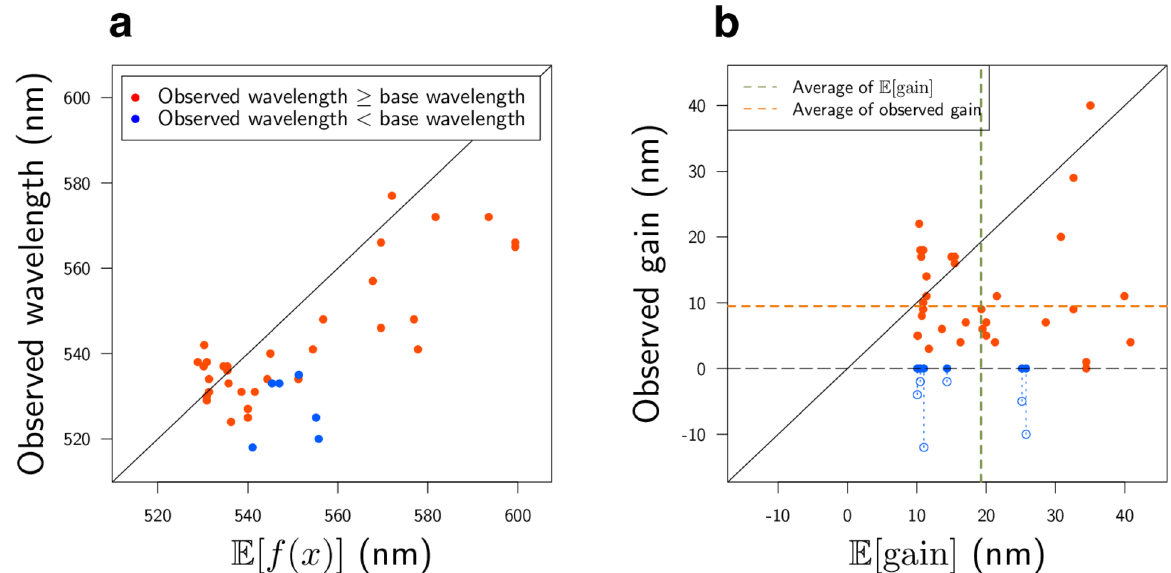
Fig. 8 Comparisons of experimental observations and ML predictions. In these two plots, the red points have longer observed wavelengths than the base wavelength λ base , while the blue points have shorter observed wavelengths than λ base . a ML-based prediction of λ max (horizontal axis) vs. experimentally observed λ max (vertical axis). b Expected red-shift gain (horizontal axis) vs. observed gain (vertical axis). Since we selected rhodopsins having expected red-shift gains of ≥ 10 nm, all the points on the horizontal axis are ≥ 10 nm. The observed gain, de fi ned by max ( λ max − λ base ,0), is nonnegative by de fi nition. For blue points whose observed gain is equal to 0, the value of λ max − λ base is also shown as blue outlined circles. The green and orange dashed lines are the averages of the horizontal and vertical axes (19.2 nm and 9.5 nm), respectively. The results indicate that the observed wavelengths and red-shift gains tended to be smaller than the predicted ones. We conjecture that these differences between the observed and predicted wavelengths are due to modeling errors (see the Discussion for